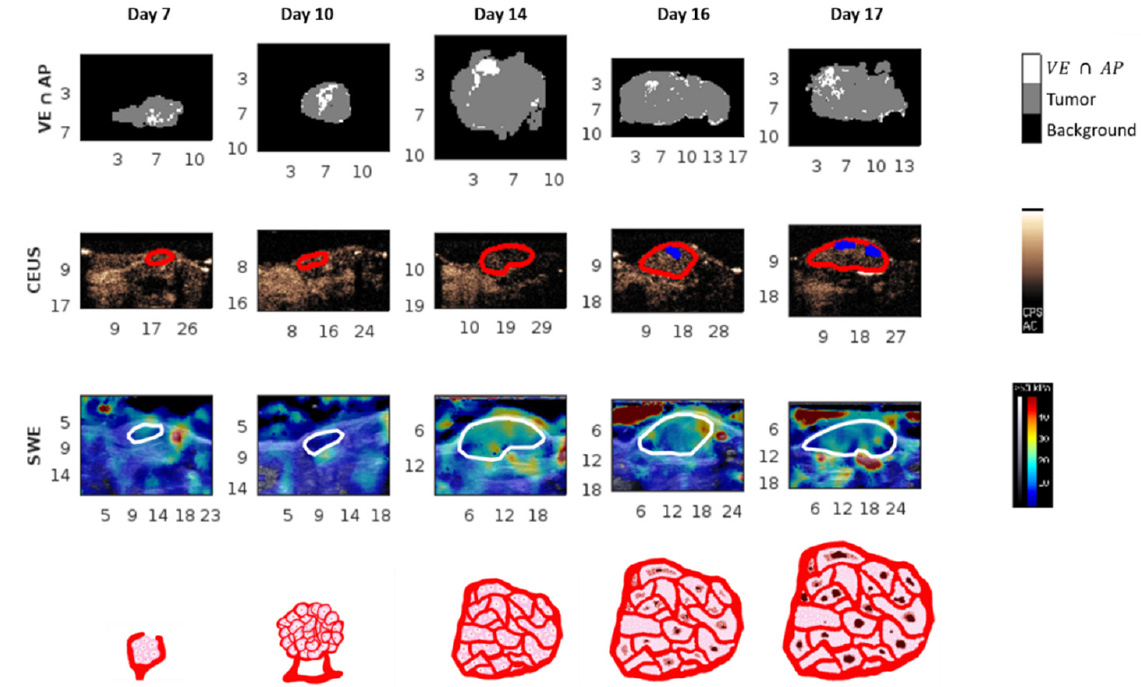
Figure 3. Example of a parametric map over time. Each column (day) shows data from the same tumor. Scales at the border of images are in millimeters. The first row is a representation of the immunohistological images of co-localization of a high percent area of the vascular endothelium and apoptosis (VE ∩ AP). The second row is a snapshot of the CEUS sequence with the tumors outlined in red and the nonperfused zones in blue. The third row is the SWE parametric map with the tumors outlined in white. The fourth row represents an illustration of the biological tumor state at the tumor cell and vascular level.